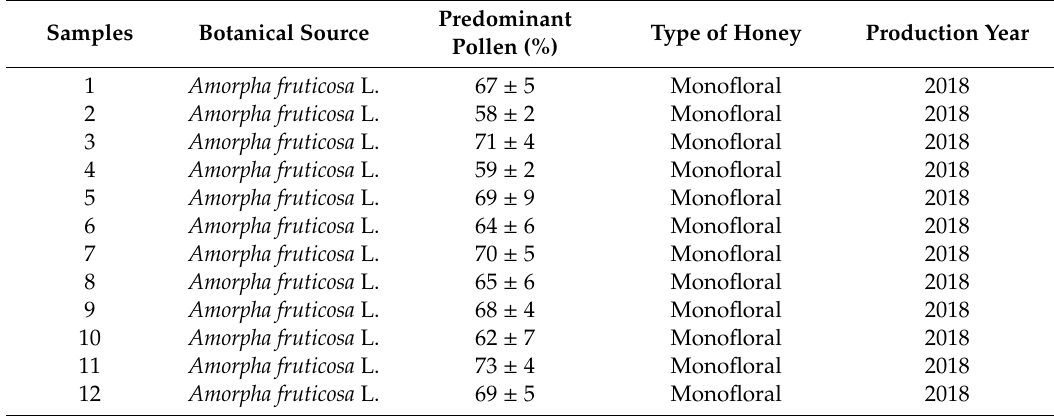
Table 2. Characterization of the analyzed AFH samples.